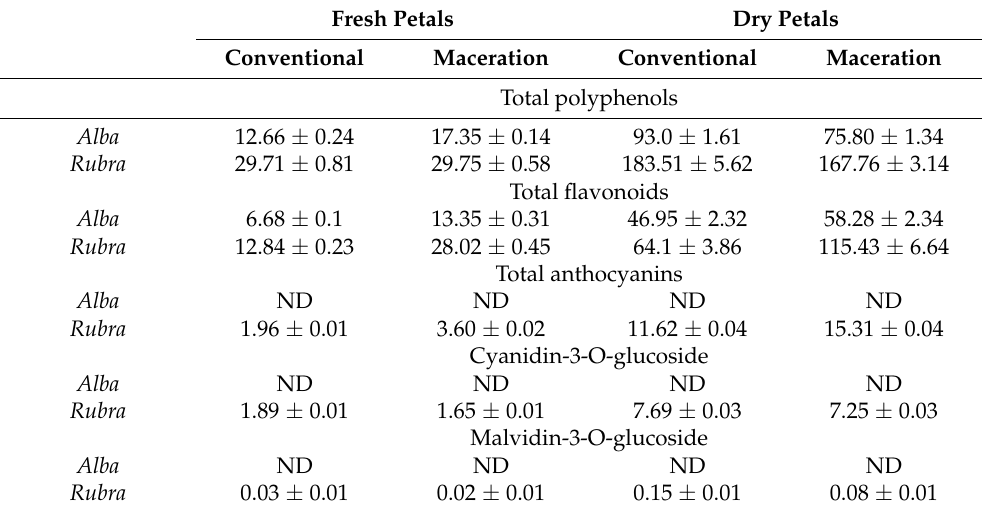
Malvidin-3-O-glucoside